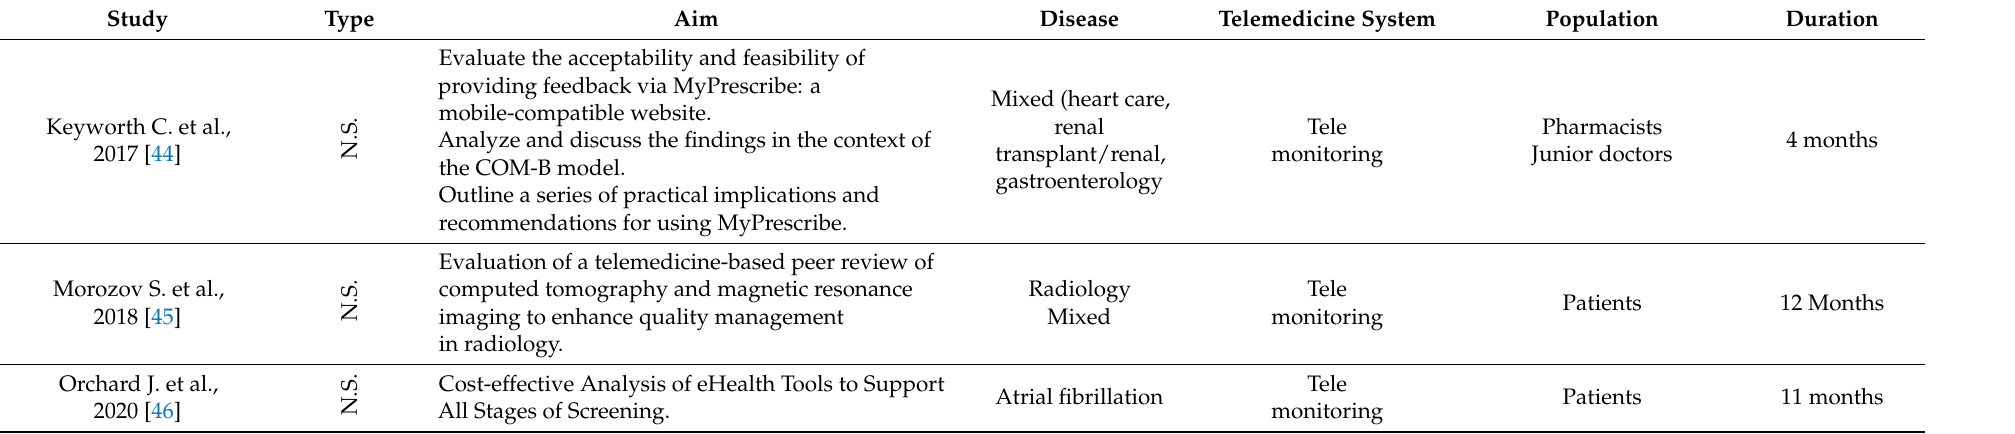
Table 2. Description of studies where audit or feedback is provided via a telemedicine